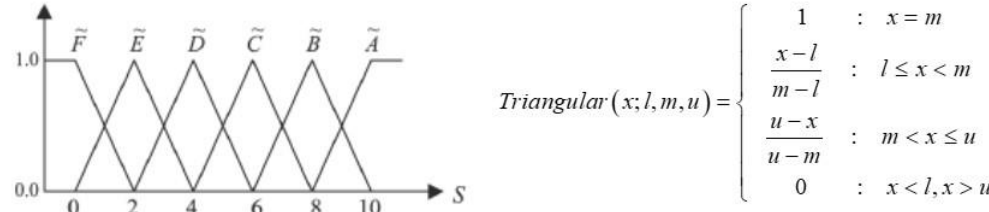
Figure 7. The triangular fuzzy grade and its membership function.